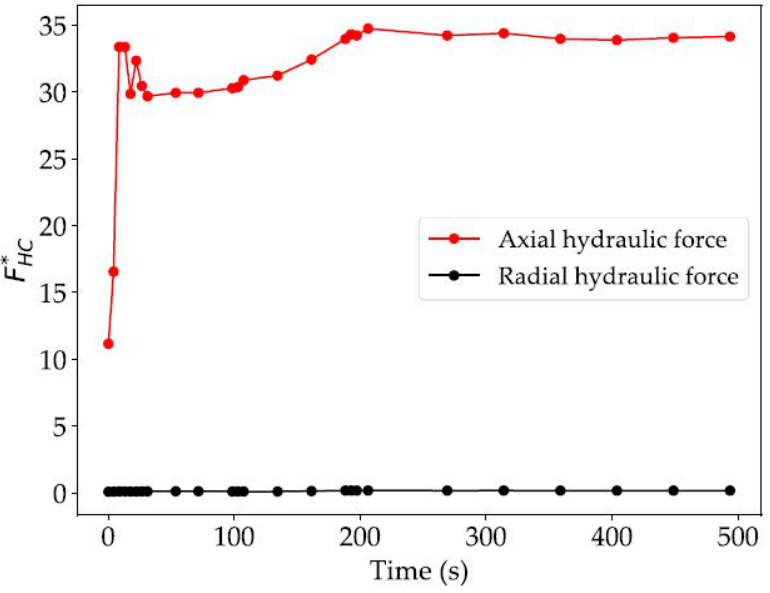
Figure 15. The relative hydraulic force coefficient of the head-cover during turbine